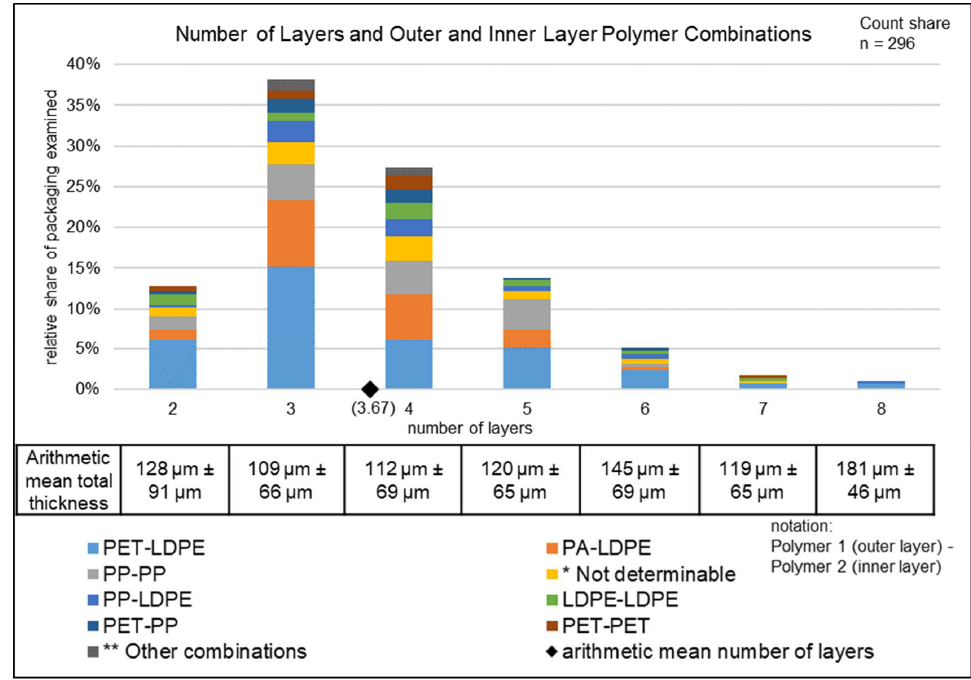
Figure 2. Numbers of layers and outer and inner layer polymer combinations in the ML sample. * PA-n.d.; PET-n.d.; n.d.-n.d.; n.d.-PP; n.d.-LDPE; ** PP-PET; LDPE-PET; PET-HDPE; LDPE-PA; PA-PP; PA-PA